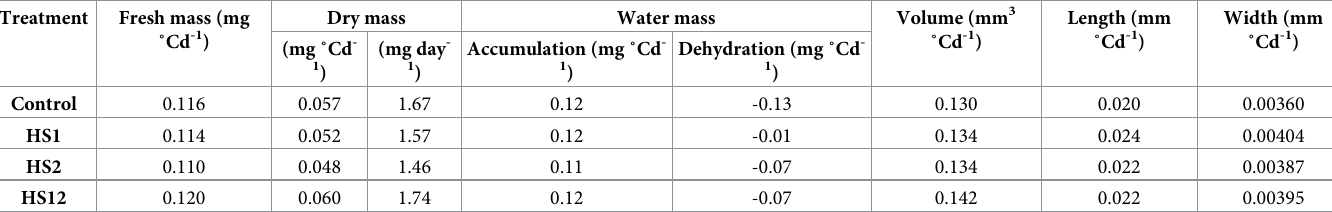
Heat shocks were applied either during the lag-phase (HS1), the grain filling-phase (HS2) or during both phases (HS12). For each grain trait, the non-linear fitting equations were compared simultaneously between treatments (Ross, 1984) and the more likely model was chosen based on the AIC criterion. Maximum values were estimated from the parameters of the most likely model. Data are estimated maximum value ± approximated SE.